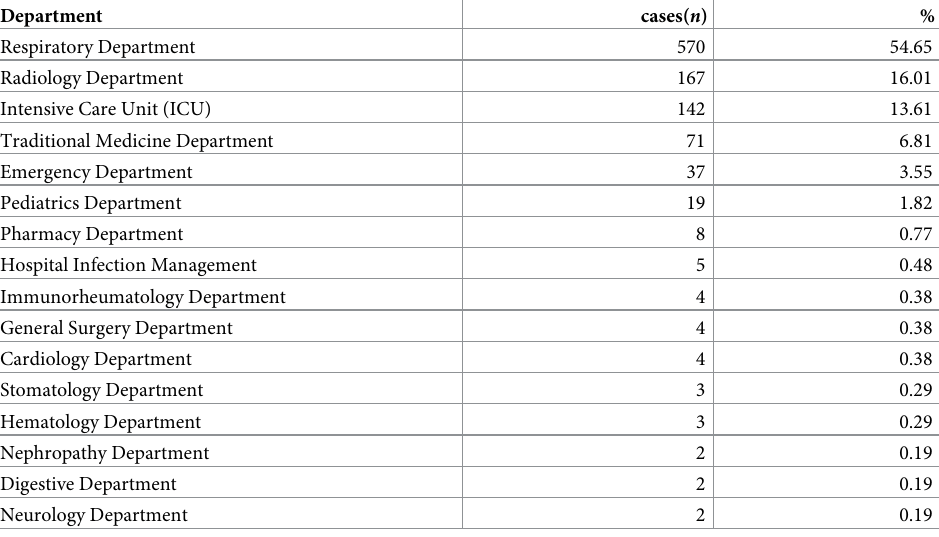
Table 1. The department of remote consultation for COVID-19 cases (n =